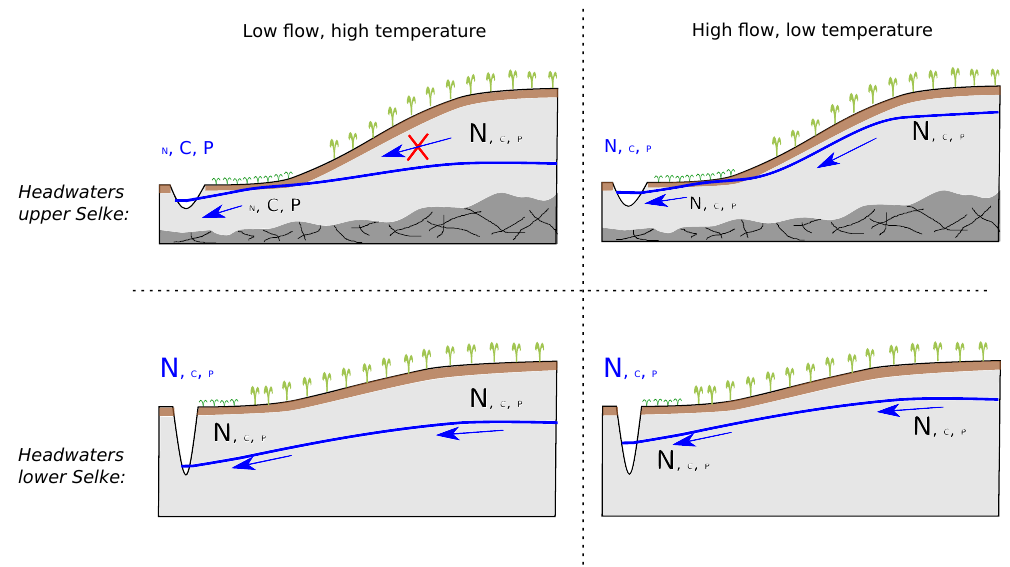
Figure 6. Conceptual model of C, N and P intra-annual variability in headwater catchments in the upper Selke (archetypes US-Agr and US-For) and in the lower Selke (archetype LS-Agr). Letter size refers to the intensity of the mass flux for each